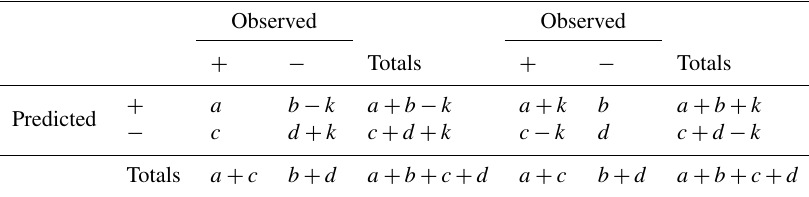
Table B2. A decrease in k Type I errors (left) and k Type II errors (right).